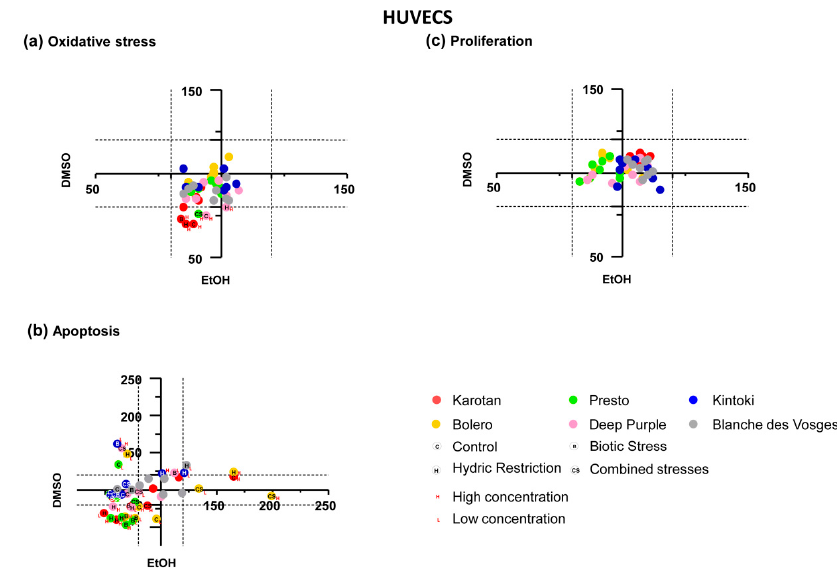
Figure A1. Effect of carrot extracts on endothelial cells. Oxidative stress ( a ), apoptosis ( b ) and proliferation ( c ) in HUVECs after treatment with carrot extract from different carrot varieties and growing conditions. In each diagram, the x-axis and y-axis expressed percentage response values of ethanol and DMSO samples, respectively. Variations of less than 20% of responses (included in dot lines) were not considered biologically significant.